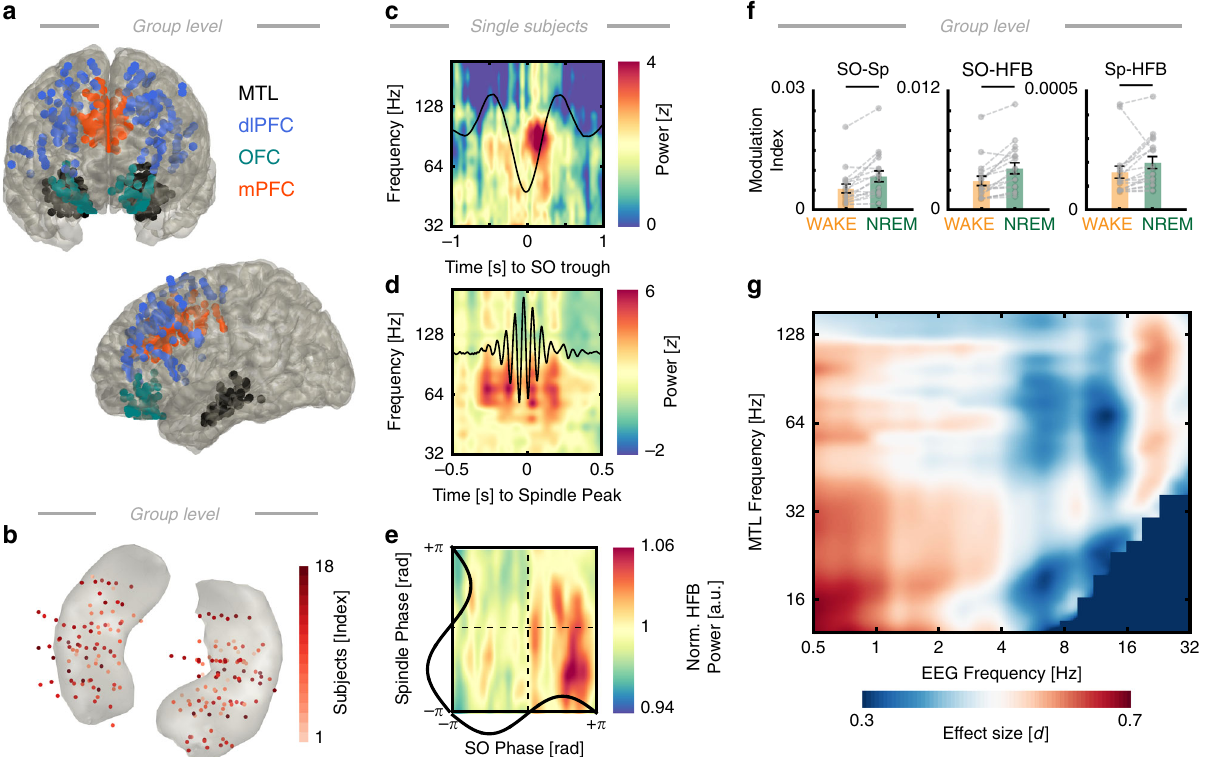
Fig. 2 Intracranial electrodes and hierarchical nesting of sleep oscillations. a Schematic depiction in MNI space of the intracranial electrode placement in the medial temporal lobe (MTL; in black) and three PFC regions-of-interest (ROI) across the subset of subjects ( N = 15) with simultaneous coverage of all three prefrontal ROIs (dlPFC: n = 167; OFC: n = 62; mPFC: n = 116). b Schematic depiction of MTL contacts ( n = 184 electrodes in 18 subjects) on a hippocampal mesh in MNI space. Note that electrode size has been rescaled for display purposes and does not re fl ect the original electrode size. Precise electrode localizations were determined in native space prior to warping to MNI space. c Single subject time-frequency spectrogram from one MTL channel relative to a rescaled trough-locked cortical average SO (black). Note the circumscribed increase in high-frequency-band activity (~80 – 100 Hz) just prior to the SO peak. d Single subject time-frequency spectrogram from one MTL channel relative to a rescaled peak-locked cortical spindle average (black). High- frequency band activity exhibited several bursts during spindle events. e Single subject, single electrode example of simultaneous nesting of HFB power in the cortical SO peak ( x -axis) and the cortical spindle trough ( y -axis). f Cross-frequency coupling analysis indicated increased SO-Spindle, SO-HFB, and Spindle-HFB coupling during NREM sleep (gray dots depict individual subjects; mean ± SEM). g Full comodulogram (wake vs. NREM) depicting the effect size of the difference (Cohen ’ s